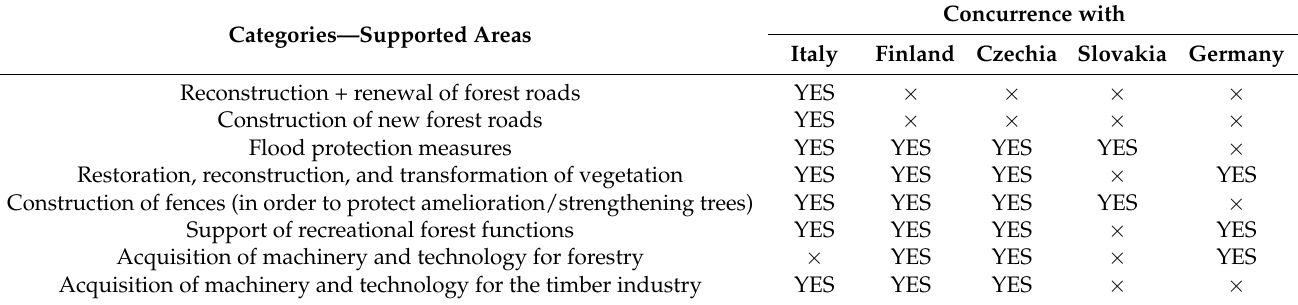
Table 4. Intersection of the individual RDP categories with perceptions of the FBEs of the se- lected